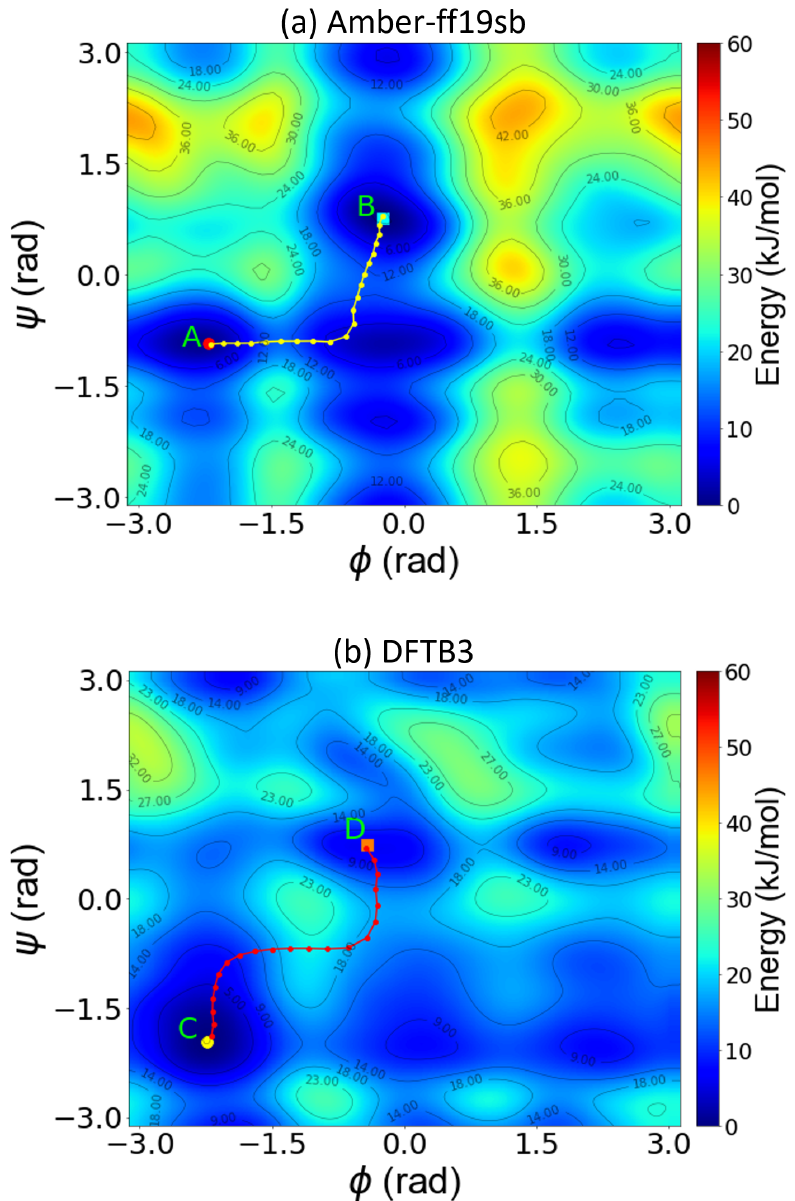
Figure 5. Two-dimensional free-energy surface of remdesivir as a function of the backbone dihedral angles, φ and ψ , obtained from well-tempered metadynamics simulations using ( a ) classical MD from the Amber-ff19SB force field and ( b ) SCC-DFTB3 calculations. Points A/B and C/D represent the dominant minima along the transition pathway (shown as a dotted line) obtained from the classical Amber force field and DFTB3 calculations,